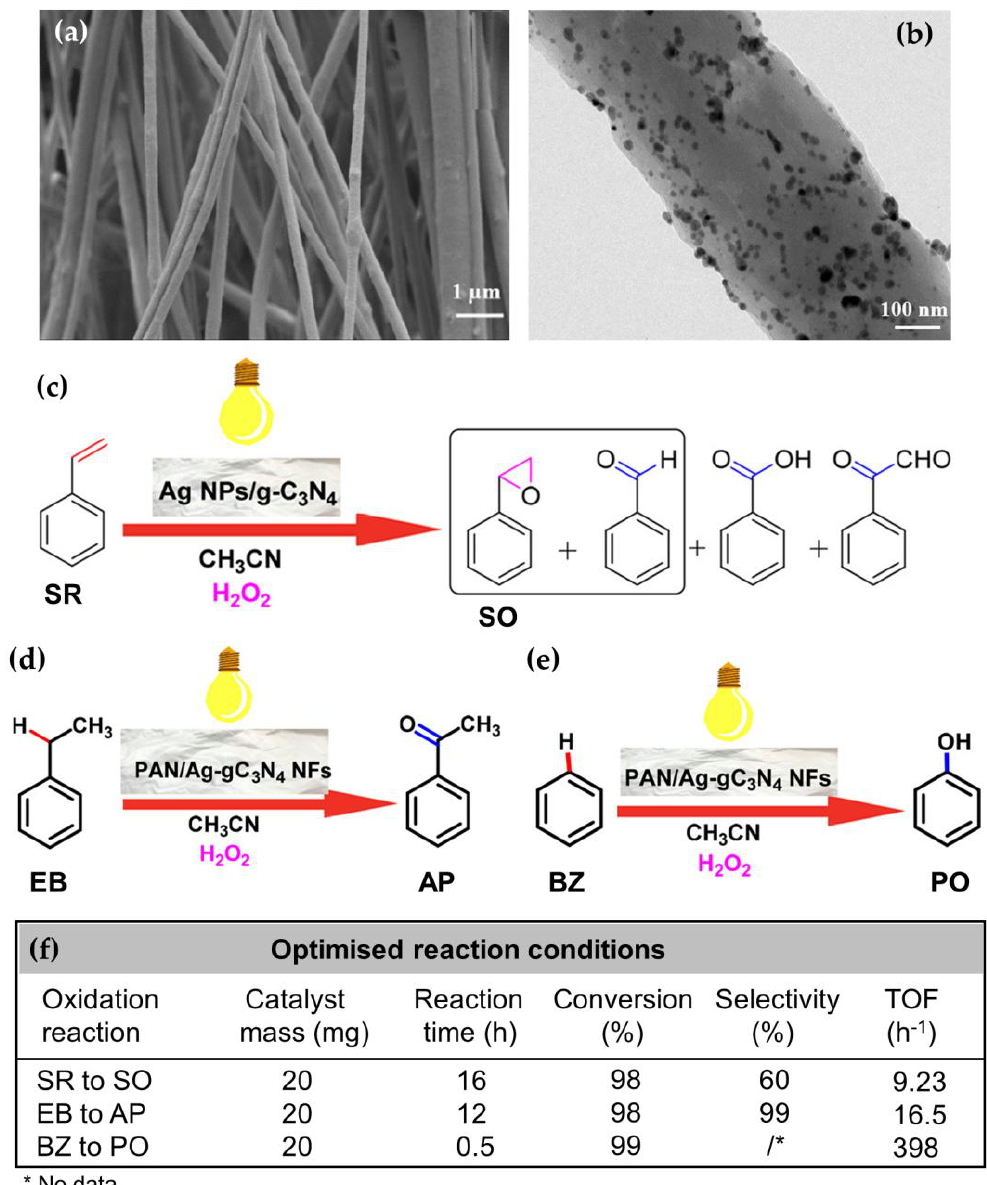
Figure 4. SEM ( a ) and TEM ( b ) images of PAN NFs with the embedded Ag NPs/g-C 3 N 4 ; schematic presentation of oxidation of styrene (SR) to styrene oxide (SO) ( c ), selective oxidation of ethylbenzene (EB) to acetophenone (AP) ( d ), and selective oxidation of benzene (BZ) to phenol (PN) ( e ) by PAN NFs, with the embedded Ag NPs/g-C 3 N 4 as a catalyst under visible light irradiation, and optimized reaction conditions with the turnover frequency (TOF) values ( f ). Reprinted with permission from